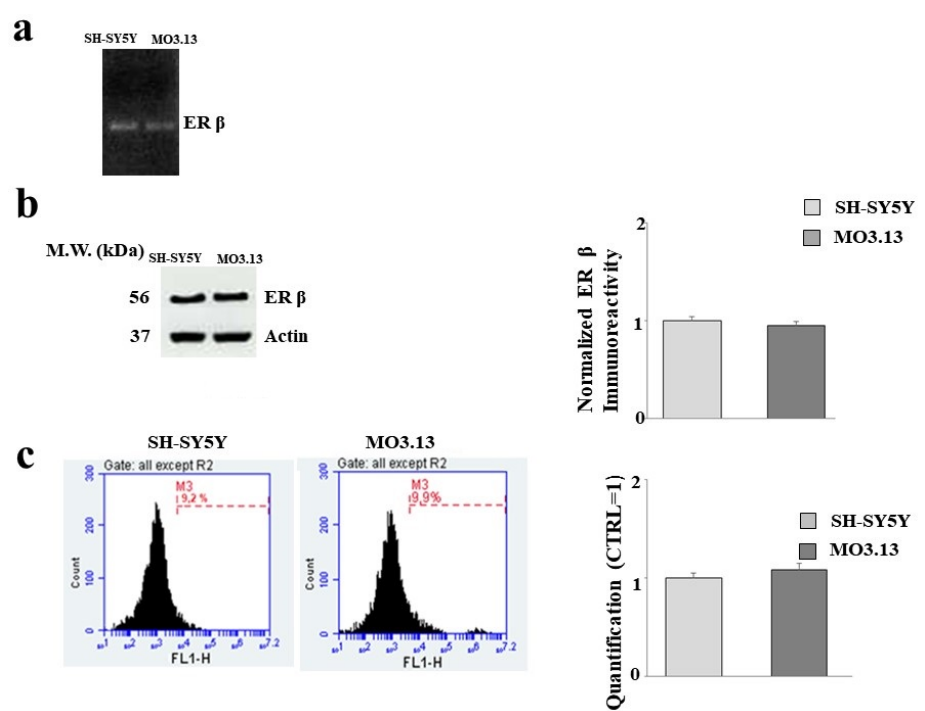
Figure 1. Expression of ER- β . ( a ) The evaluation of genetic information of ER- β by RT-PCR is represented in SH-SY5Y and MO3.13 grown in a co-culture. A representative experiment of three independent experiments (which reported the same results) is shown, and values are expressed as the mean ± standard deviation (sd). The expression of ER- β in both cell lines is represented in panel ( b ), and the resulting values were normalized for the housekeeping protein actin. As shown in panel ( c ), the expression of ER- β was also evaluated by cytometry. For each cytometric reading, 10,000 events were acquired, and in every plot, M3 was used as an arbitrary marker to record variations in fluorescence (a representative experiment from the three independent experiments). Relative quantification was obtained by placing the value obtained for the neurons (1) and comparing the values of the oligodendrocytes. An experiment representative of the three independent experiments that reported the same results is shown. Values are expressed as the mean ± standard deviation (sd). All three methods showed equal levels of ER- β in both cell lines.